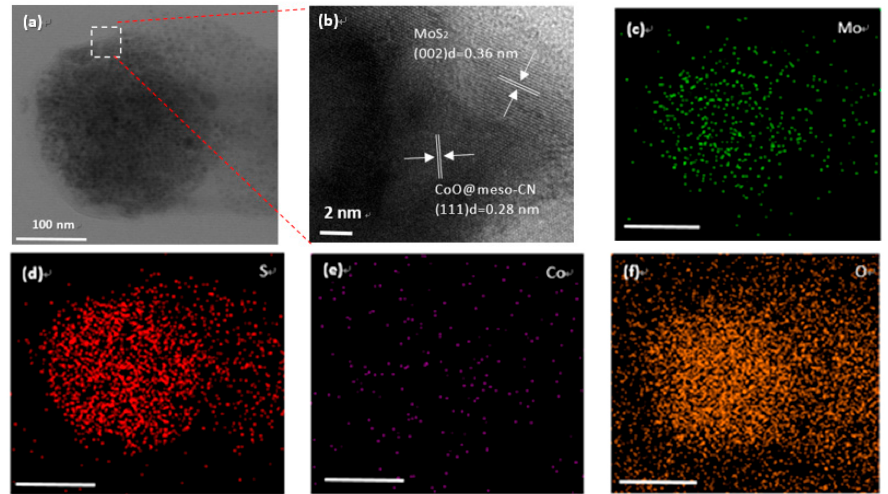
Figure 3. FESEM images of ( a ) pure MoS 2 , ( b ) 3 wt%, ( c ) 5 wt% CoO@meso–CN@MoS 2. photocatalysts, and ( d ) EDS pattern of 3 wt% CoO@meso–CN@MoS 2 .